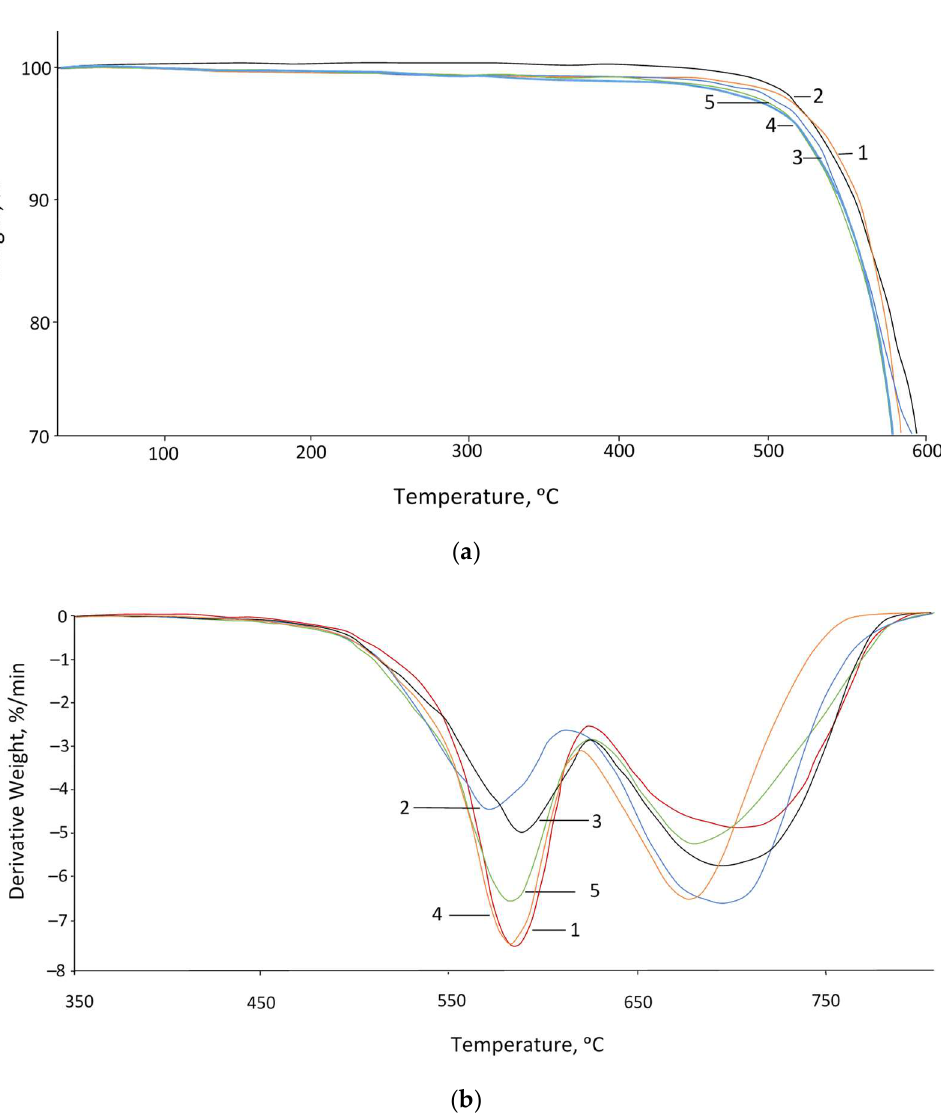
Figure 5. Mass loss curves ( a ) and derivatives of a mass loss curves ( b ) for PPSU blends: 1—PPSU- 17; 2—PPSU-6/38; 3—PPSU-2/54; 4—PPSU-3/292; 5—PPSU-3/n/f. 2—PPSU-6/38; 3—PPSU-2/54; 4—PPSU-3/292; Table 2. Thermogravimetric analysis of PPSU blends.